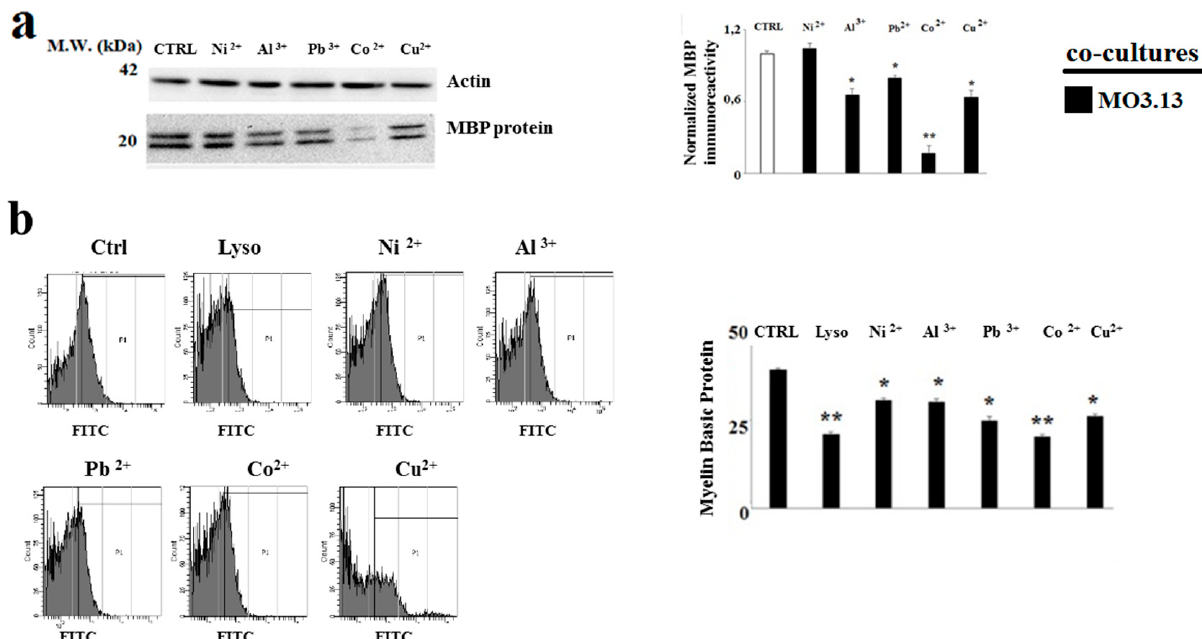
Figure 8. Co-culture-derived oligodendrocytes. Measurement of expression of Myelin Basic Protein (MBP) through Western blotting and flow cytometric analysis. Di ff erentiated human oligodendrocytes and human neurons were grown in co-culture and treated with heavy metals for 24 h. At the end of the treatment, the total lysates of the samples were subjected to western blotting analysis. In case of flow cytometric analysis, at the end of the treatment, the cells were fixed and permeabilized in the Cytofix / Cytoperm solution and treated with rabbit polyclonal antibody for Myelin Basic Protein. As a secondary antibody, it was decided to use an anti-rabbit conjugated with fluorophore FITC. Panel ( a ) shows the MBP expression in oligodendrocytes under the indicated conditions. The quantification is visible on the right of the panel. Panel ( b ) shows the MBP expression in oligodendrocytes obtained through flow cytometric analysis. The quantification is visible on the right of the panel. Values of three independent experiments are expressed as mean ± standard deviation (sd). * denotes p < 0.05 vs. control; ** denotes p < 0.01 vs. control. Analysis of Variance (ANOVA) followed by the Tukey-Kramer comparisons